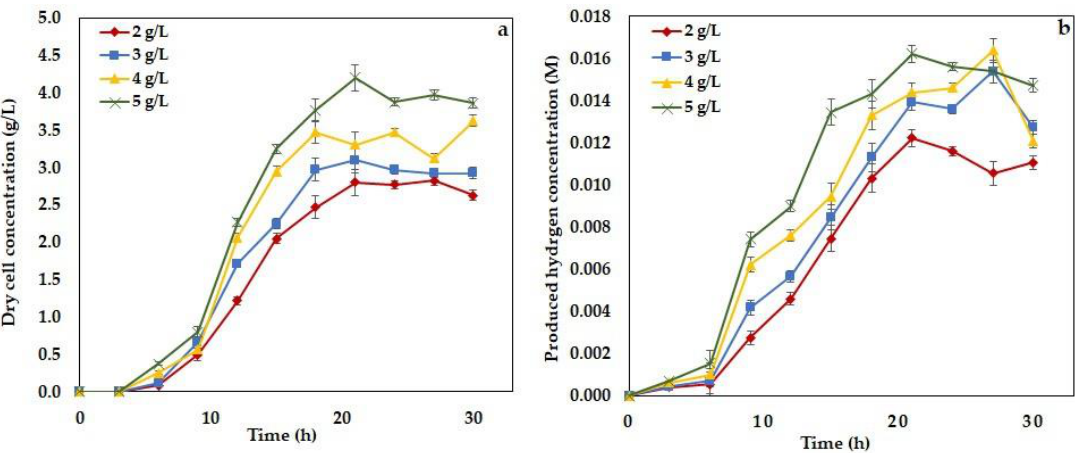
Figure 5. Experimental time histories of dry cell concentration ( a ) and hydrogen concentration ( b ) with initial 0% H 2 in reactor headspace at different substrate concentration.